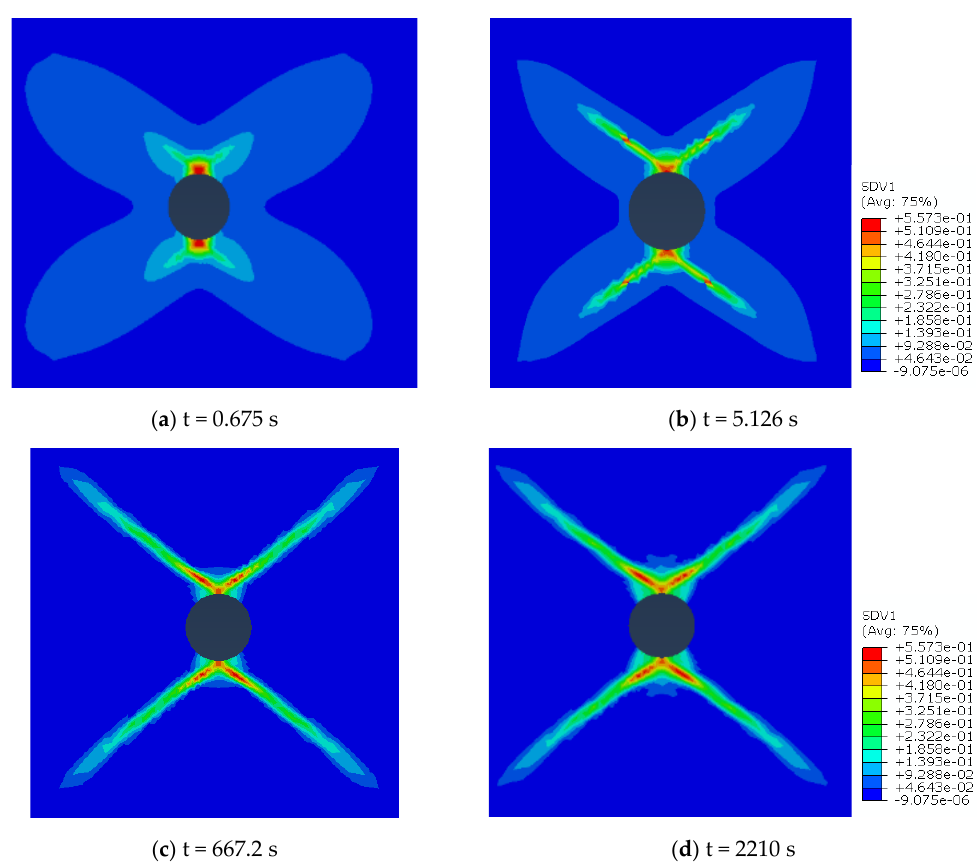
Figure 3. Evolution of equivalent plastic strain region (SVD1 represents equivalent plastic strain).